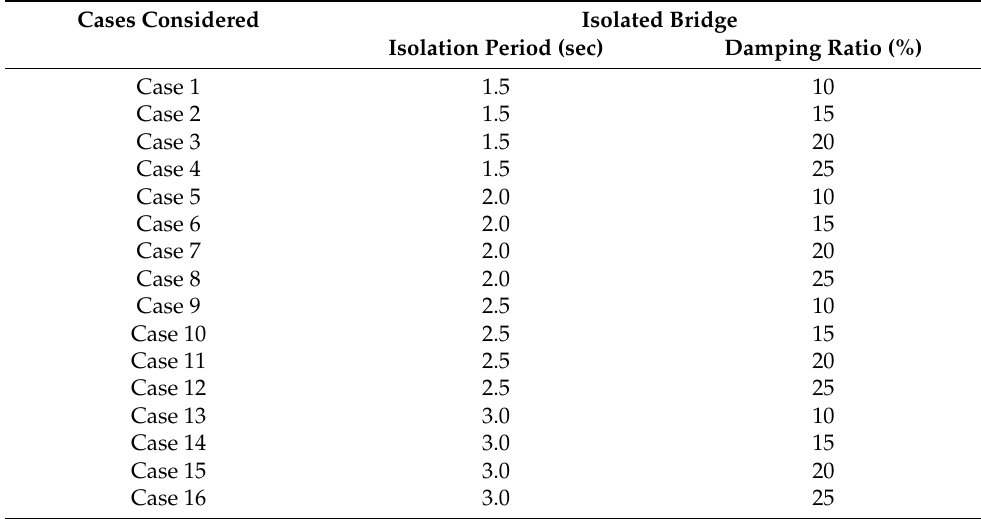
Table 4. Different cases considered for the Isolated